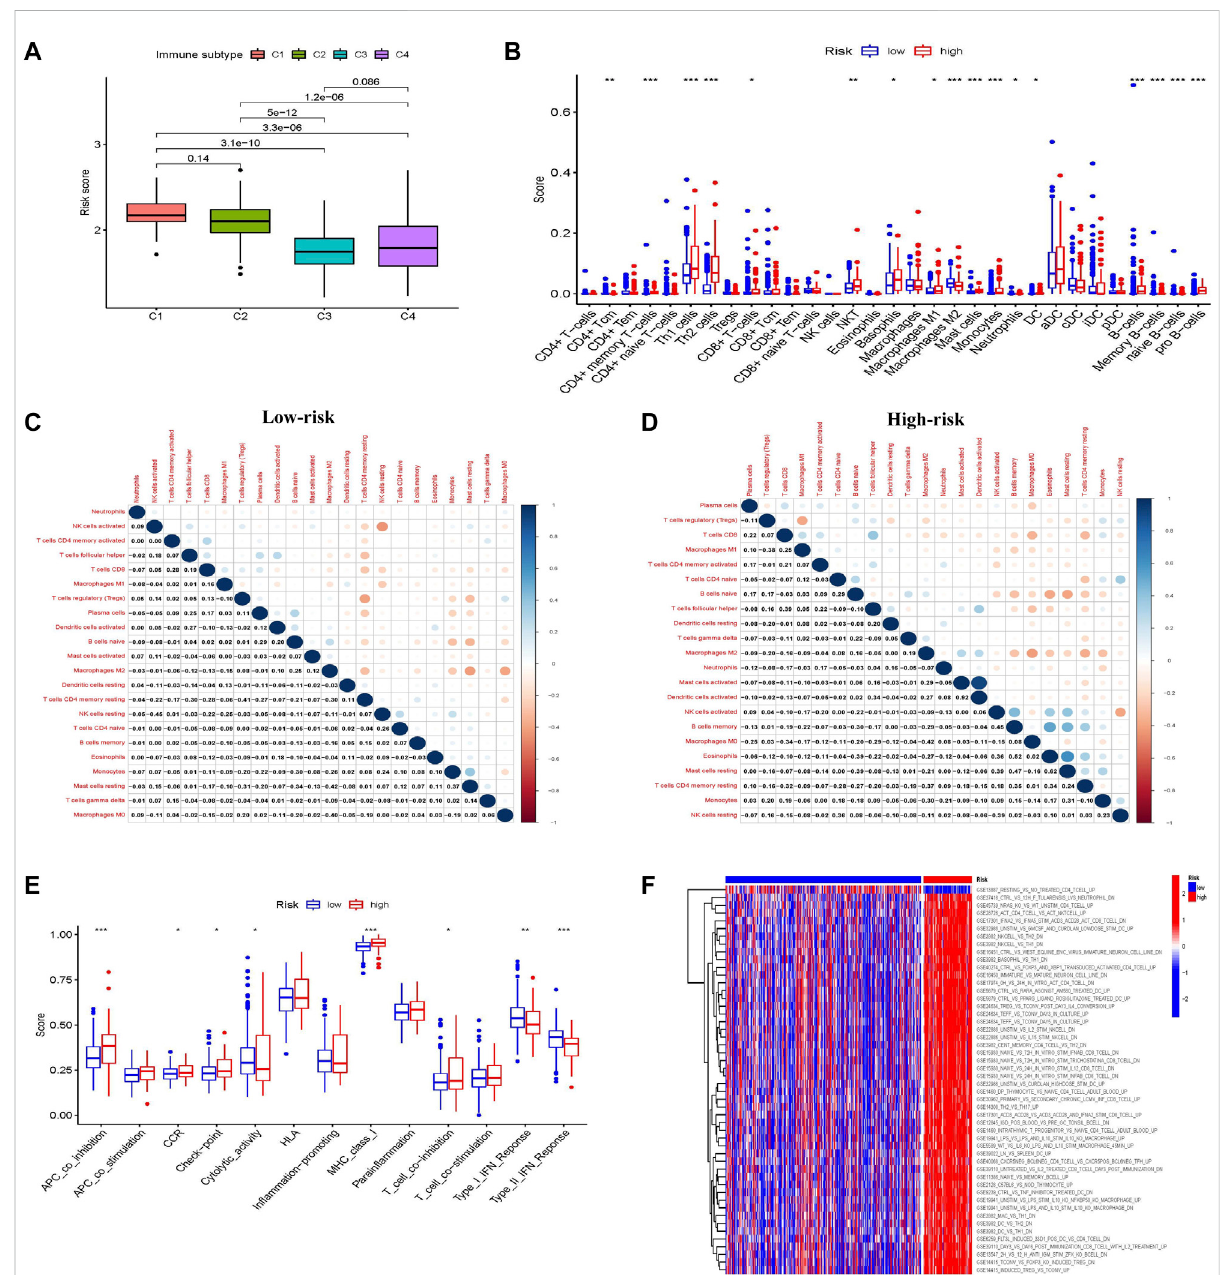
FIGURE 5 Characteristics, functions, and pathways of immune in fi ltrating cells in patients with liver cancer in different glycometabolism-related risk scores. (A) Analysis of theimmune subtype ofdifferentrisk scores. (B) The proportion of immune cells in thetumor microenvironment with different risk scores. (C,D) Correlations between immune-in fi ltrating cells in low-risk and high-risk scores, respectively. (E) Comparison of immune cell function between low-risk and high-risk scores. (F) Heatmapcomparisonofimmune-related pathway enrichmentbetweenlow-risk andhigh- risk scores. * p < 0.05, ** p < 0.01, *** p < 0.001, **** p <